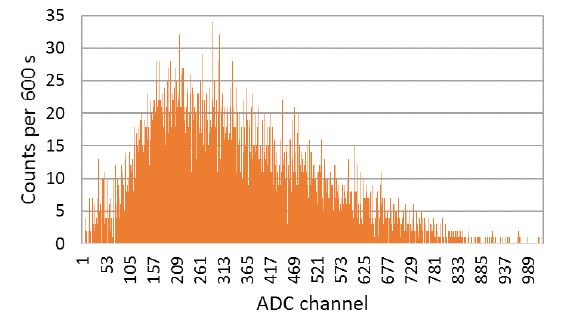
Figure 12. Spectrum from EJ-426HD detector considering a 33.3 MBq (0.9 mCi) Am-Be source at 2 cm distance.